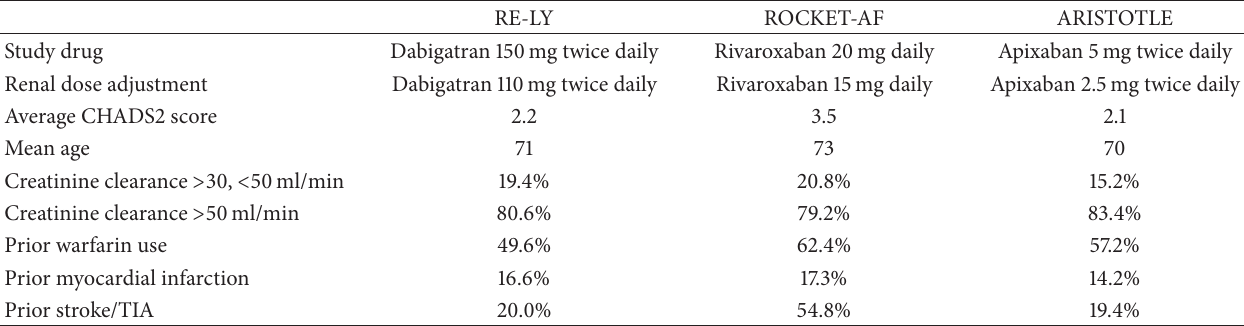
Table 1: Baseline characteristics for novel oral anticoagulant trials.